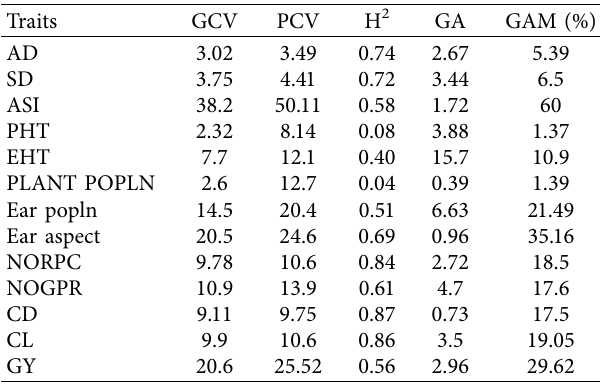
Table 3: Estimation of genetic parameter of tested 13 traits. Traits